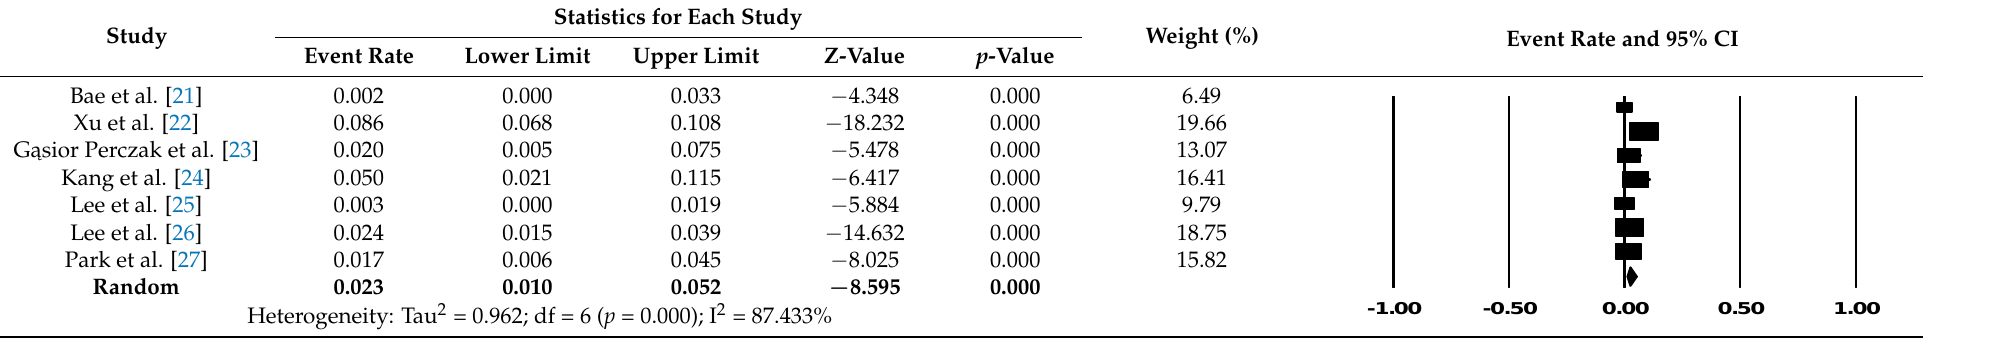
Table 2. Recurrence rate in patients who received TSH maintenance less than 2 mU/L after thyroid lobectomy for low-risk differentiated thyroid cancer.